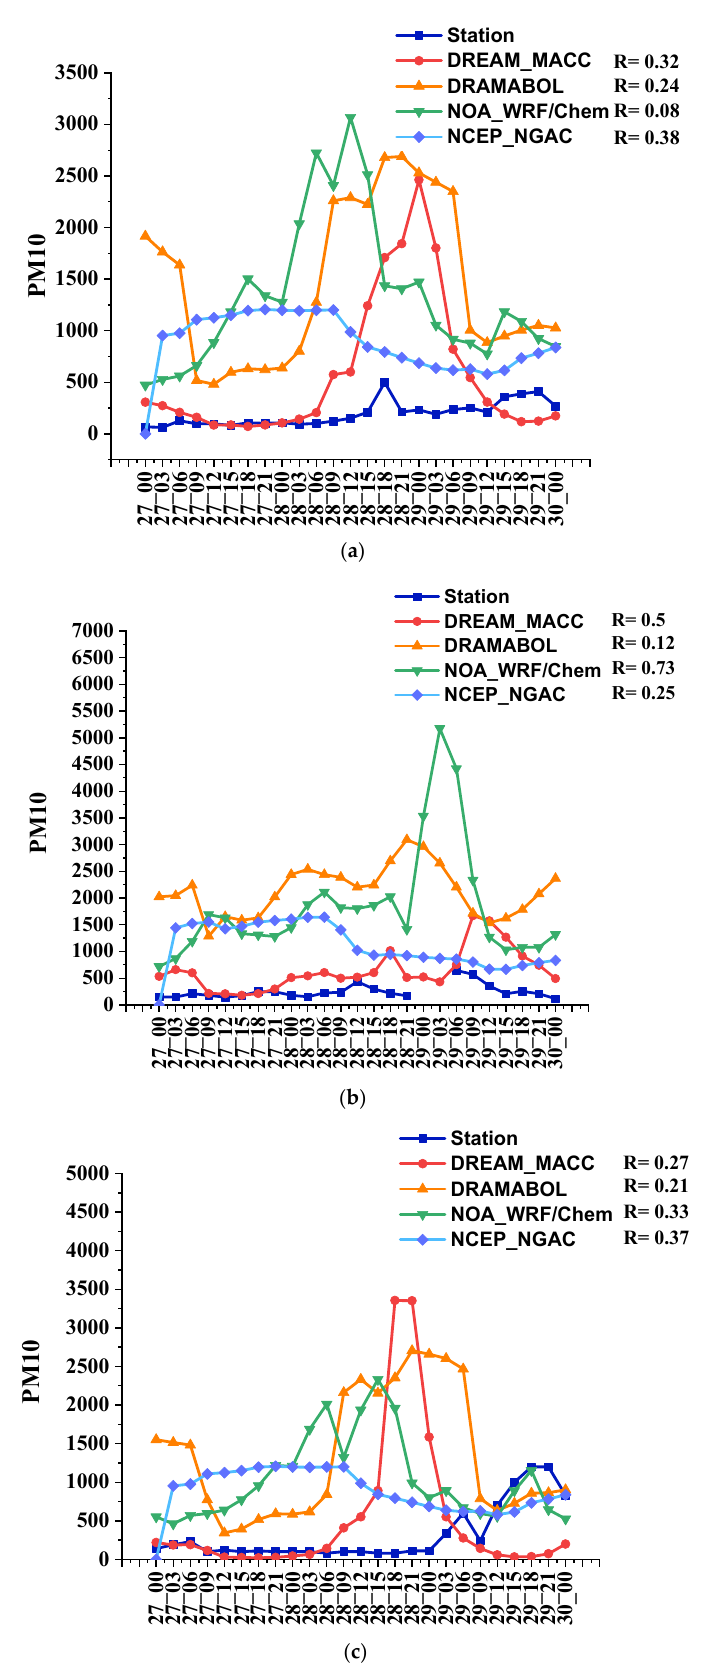
Figure 11. The PM 10 concentration (µg/m 3 ) of the four models output and the dust monitoring stations in ( a ) Urmia ( b ) Bokan ( c ) Sardasht stations around Lake Urmia from 27 to 30 October.